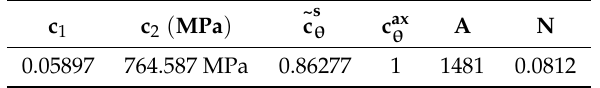
Figure 3. Damage evolution behavior under cyclic loadings with different values of C g . Table 2. Material parameters used in the modified Mohr–Coulomb (MMC) criterion in Equation (6).